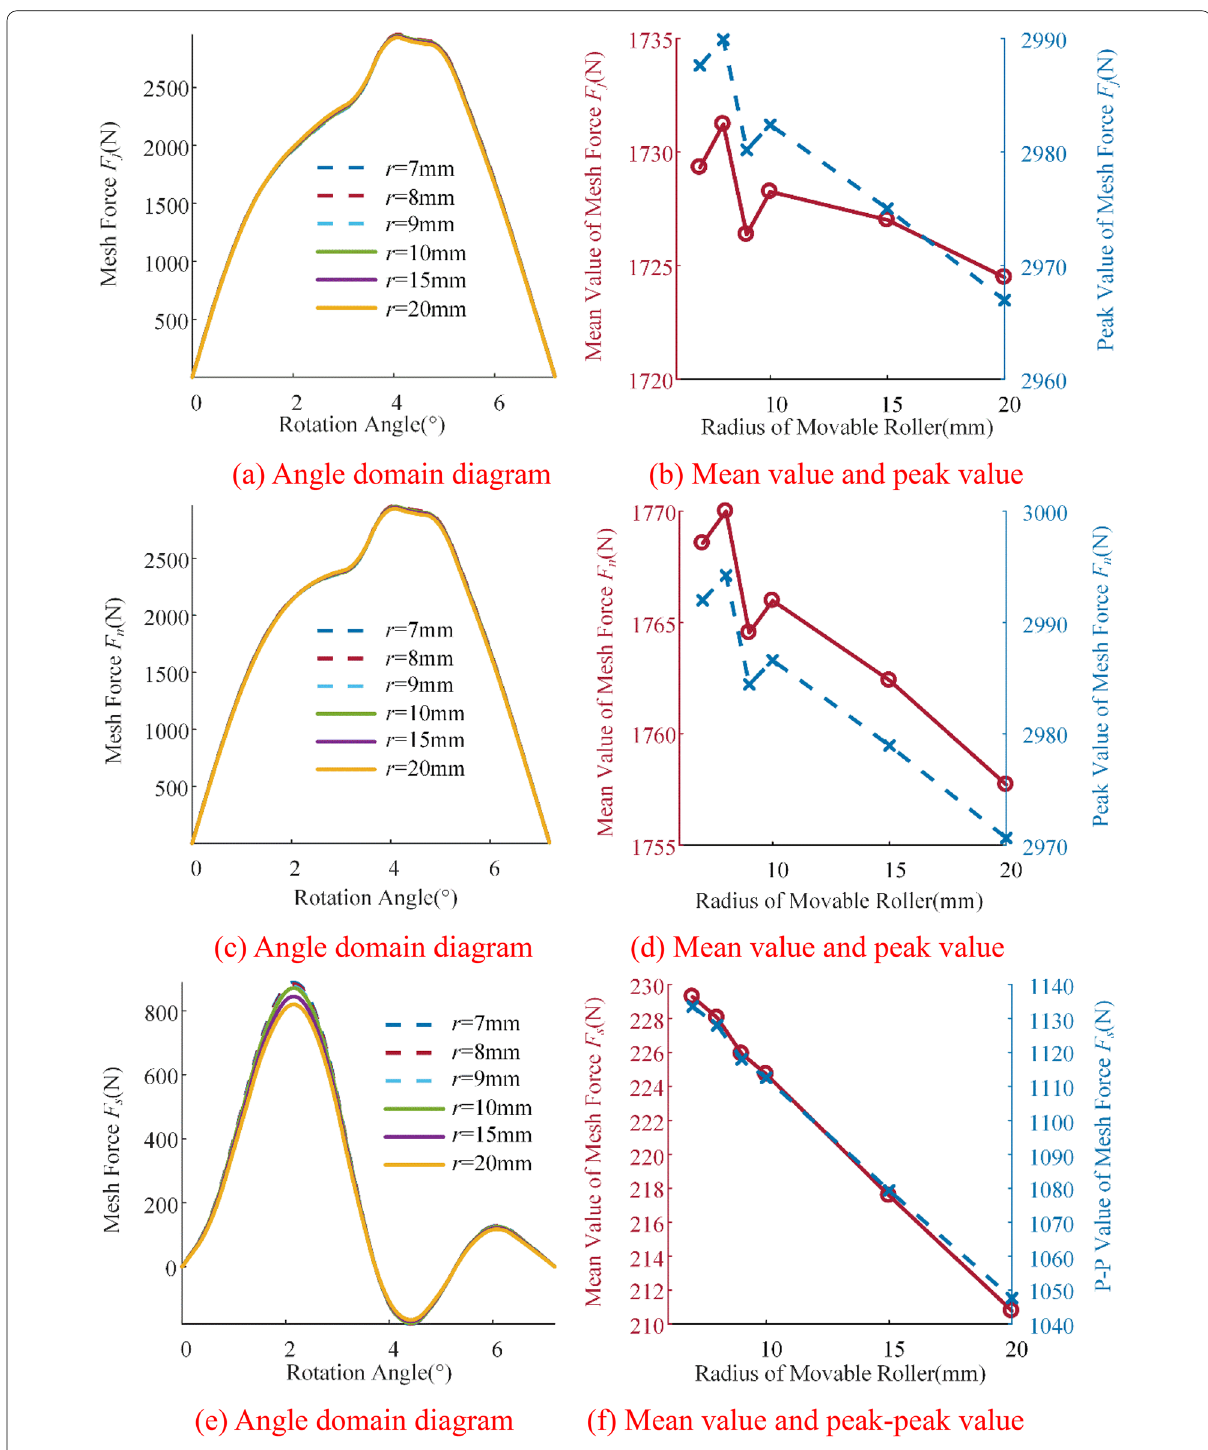
Figure 12 Impacts of radius of movable roller on mesh